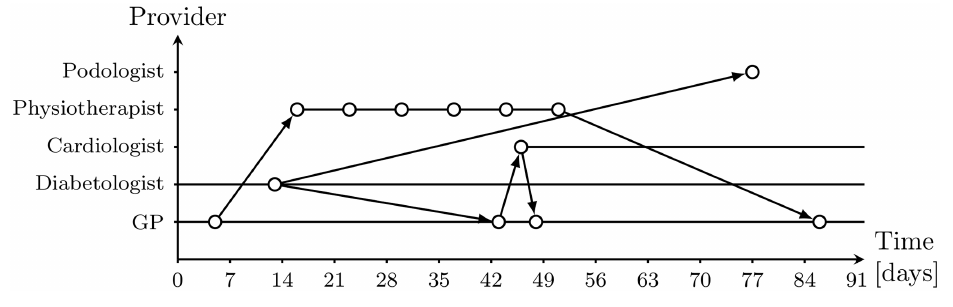
Fig 1. A fictitious example of a health care utilization